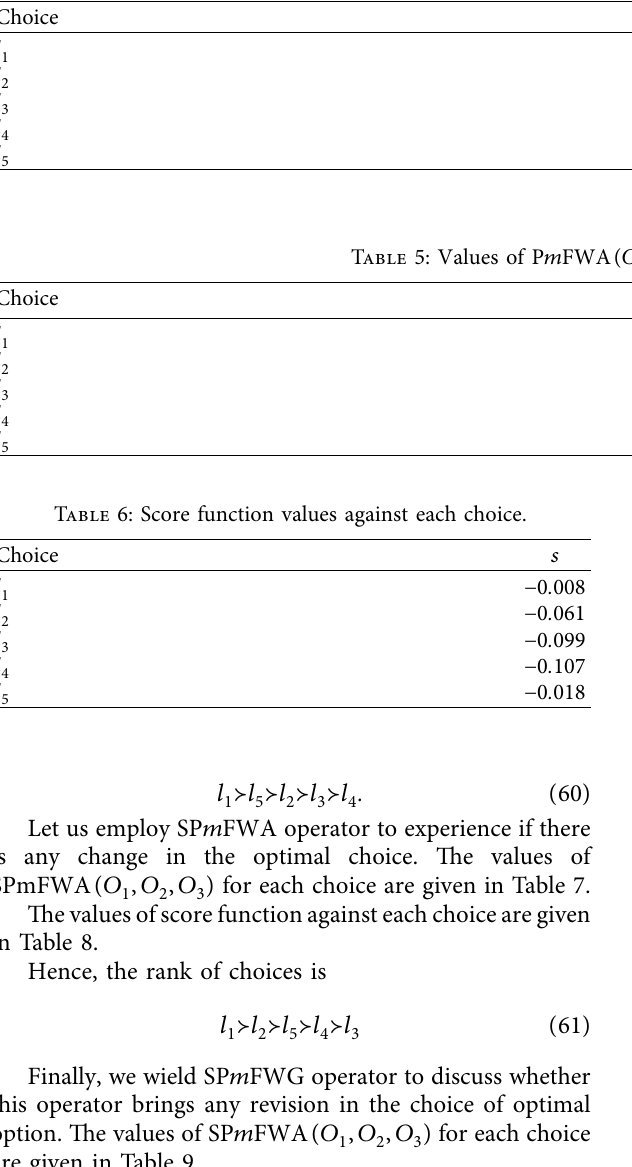
Table 4: Values of score function against each choice.